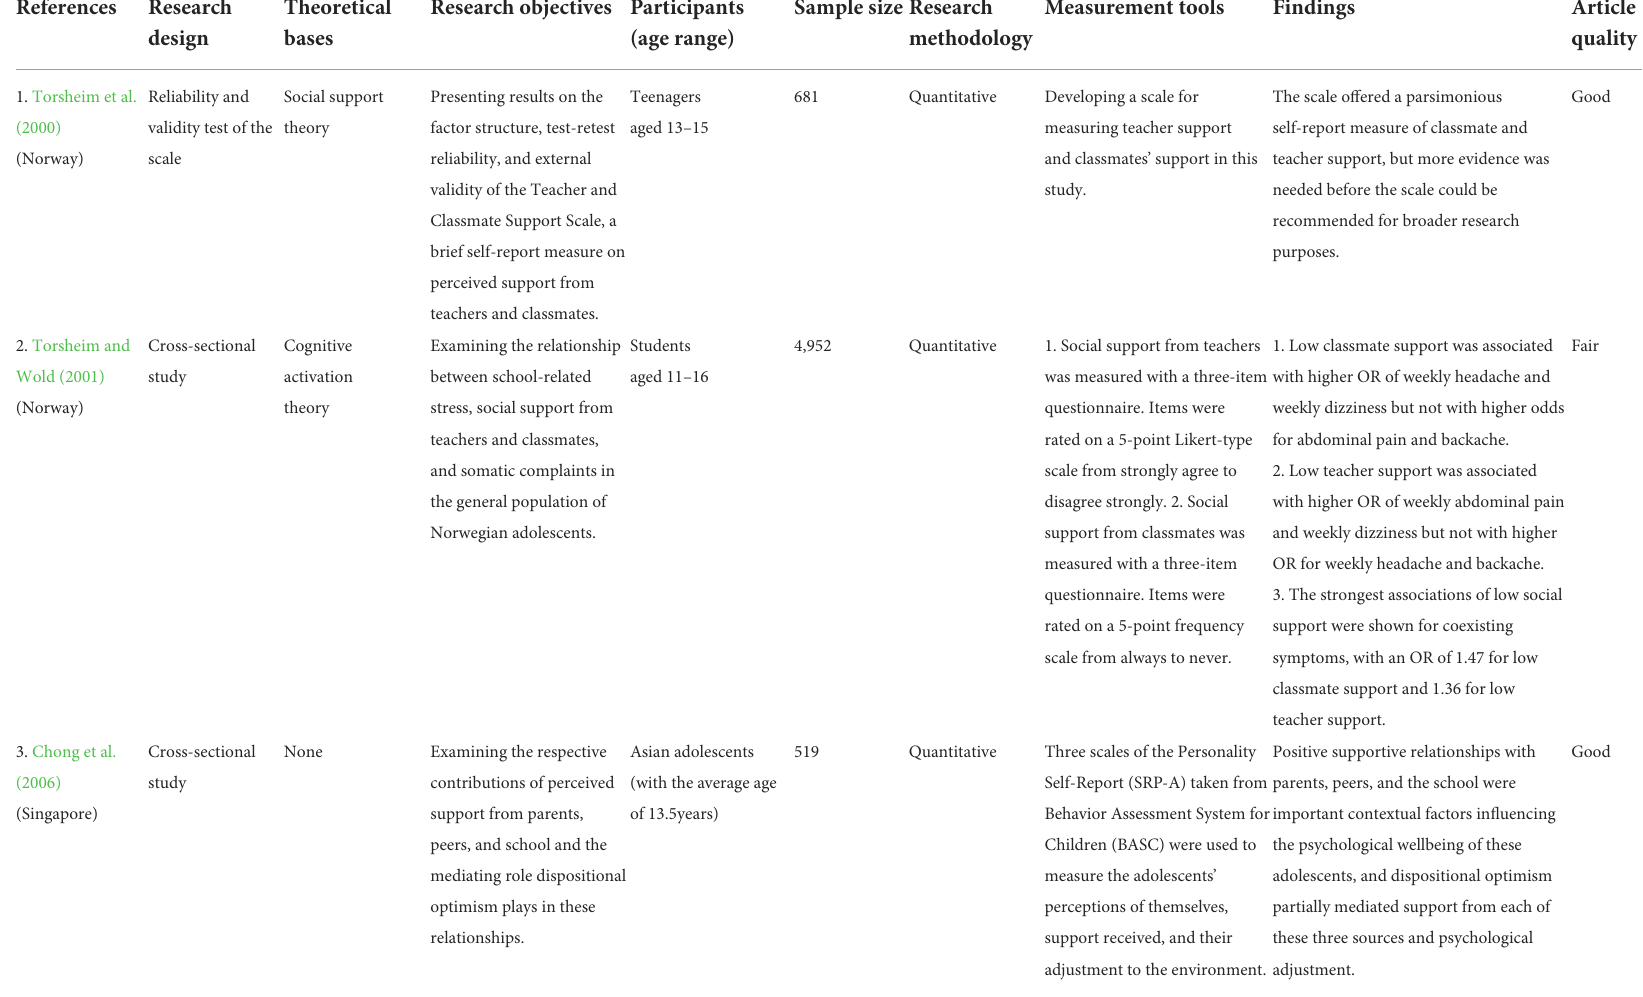
TABLE 4 Summary of included English core-journal articles ( n =